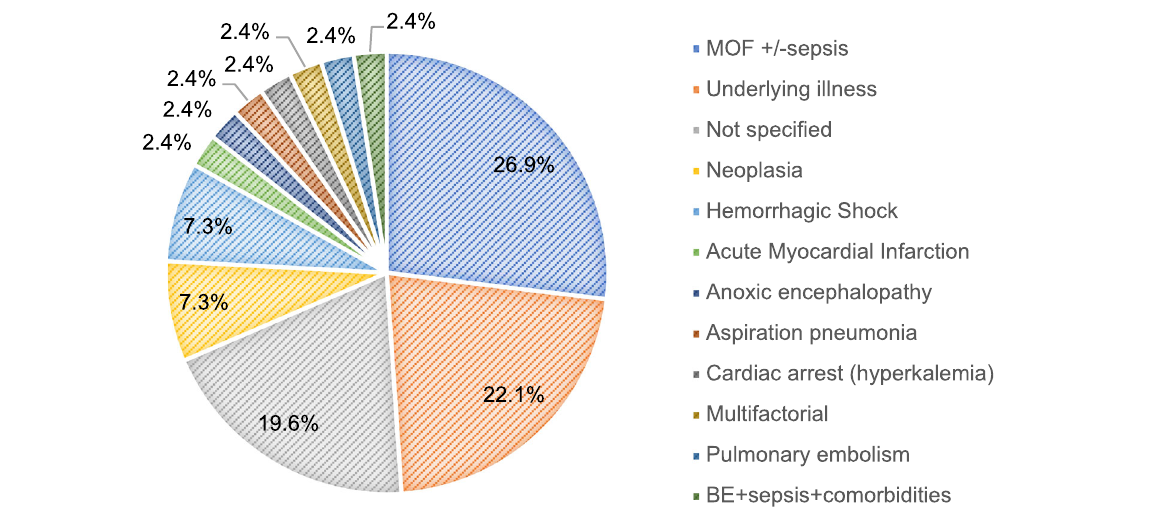
Fig. 2 Causes of death in the endoscopy series classified by their frequencies. MOF multiple organ failure, BE black